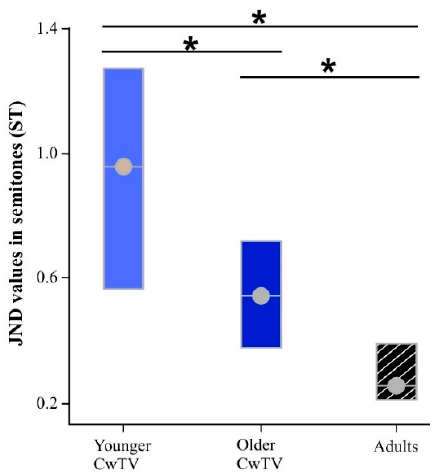
Figure 3. Medians and 95% confidence intervals for the just-noticeable-di ff erence (JND) values in semitones (ST). Markers indicate median JND values; groups that have significantly di ff erent medians at p < 0.05 are indicated by asterisk. Median confidence interval boxes indicated for the younger children with typical voices (CwTV, light blue), older CwTV (dark blue), and adult (black with white stripes)